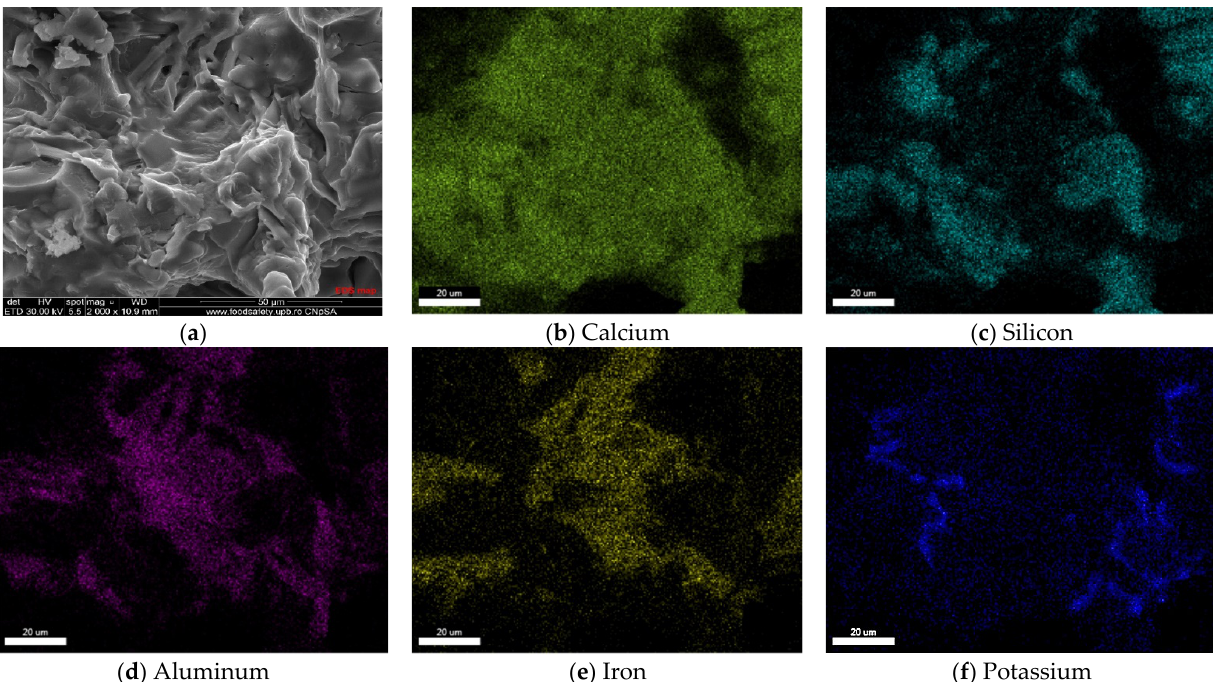
Figure 6. SEM images of Rc and Rm clinkers at different magnifications; A—alite; B—belite; C— calcium ferrite aluminate; M—melt; pores are indicated by arrows